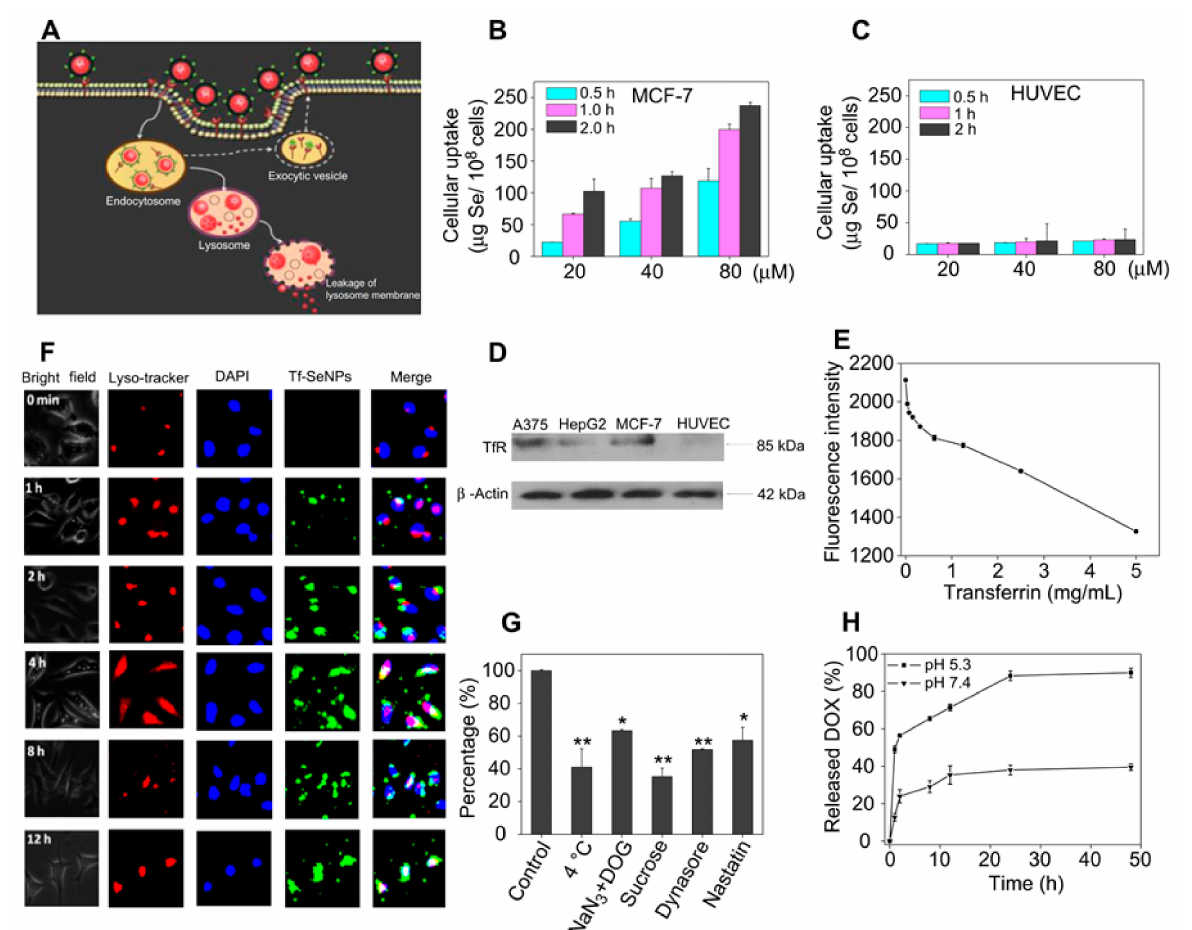
Figure 7. Proposed endocytosis pathway of Tf-SeNPs in MCF-7 cells ( A ). Quantitative analysis of cellular uptake efficacy of coumarin-6-loaded Tf-SeNPs in MCF-7 cells ( B ) and HUVEC cells ( C ). TfR expression in A375, HepG2, MCF-7, and HUVEC cells ( D ). Free Tf competed with coumarin-6-loaded Tf-SeNPs for binding to TfRs on MCF-7 cells ( E ). Intracellular trafficking of coumarin-6-loaded Tf-SeNPs ( F ). Intracellular uptake of Tf-SeNPs in MCF-7 cells under different endocytosis-inhibited conditions. Difference with p < 0.05 (*) or p < 0.01 (**) was considered statistically significant as compared to the control group ( G ). In vitro release profiles of DOX from Tf-SeNPs in PBS solution (pH 7.4 and pH 5.3) ( H )